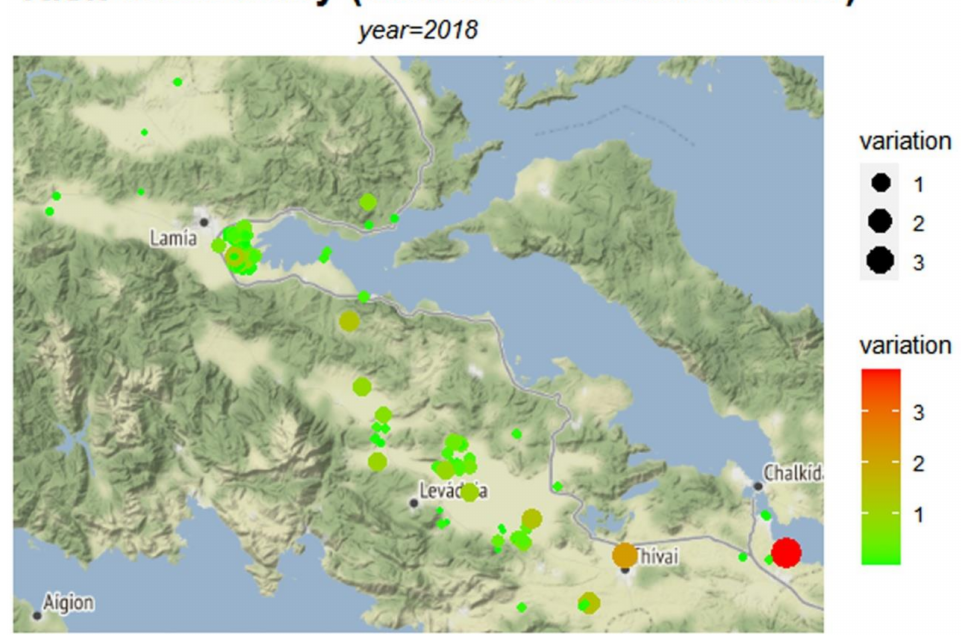
Figure 5. Uncertainty in R 0 , in the form of the standard deviation of R 0 (based on 1000